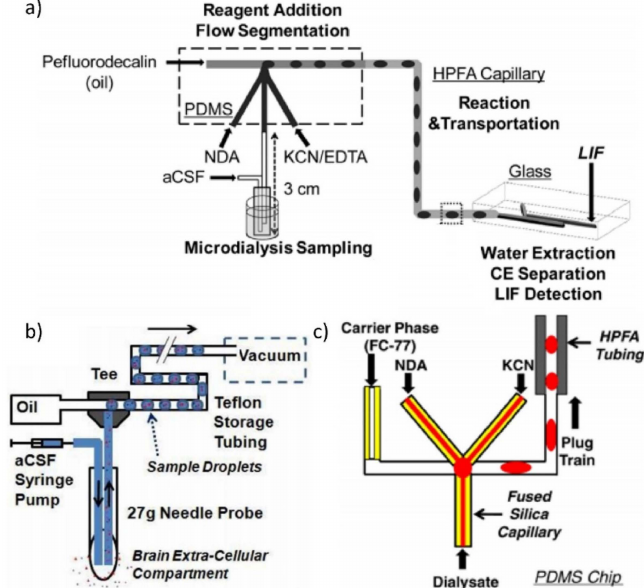
Figure 2. Continuous phase sampling with downstream droplet formation methods. ( a ) A microdialysis probe is used for sampling, coupled with a droplet generation chip to transport chemicals to a